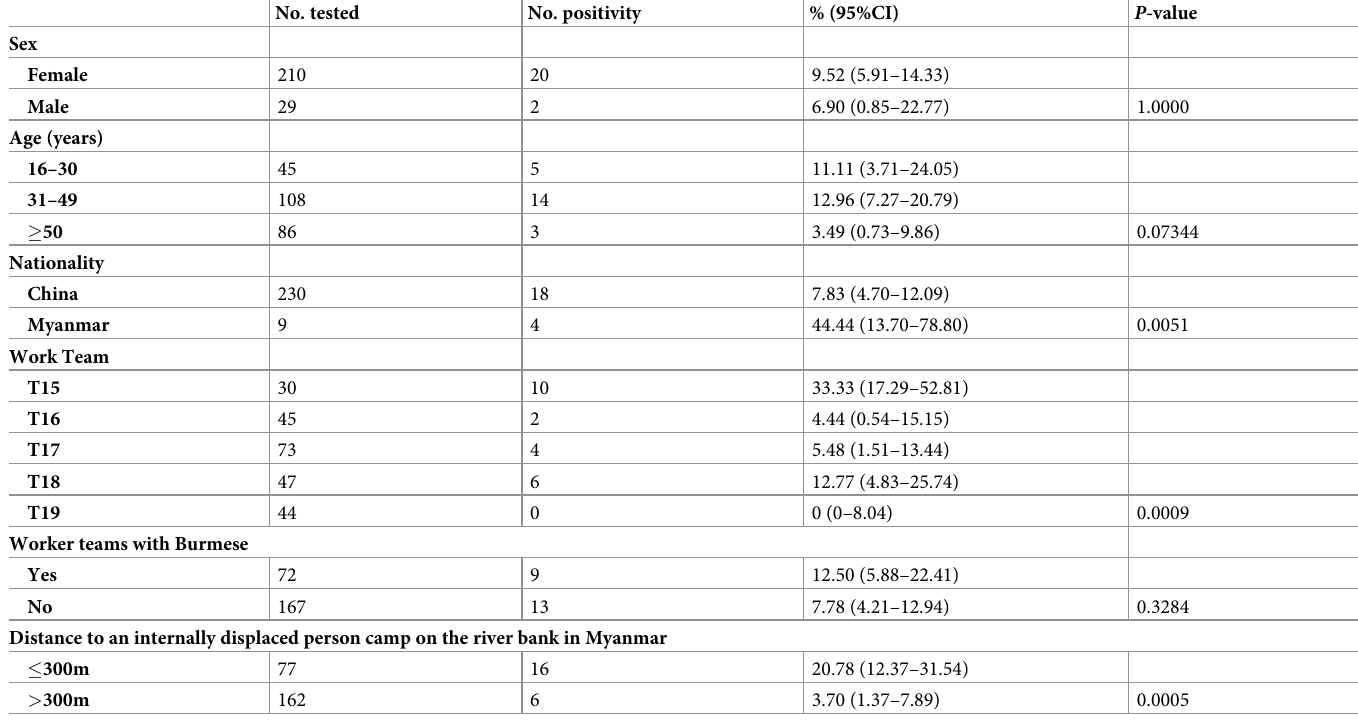
Table 2. Results of microscopy for malaria parasites, including testing at the project site and health facilities at worker’s hometowns. No. tested